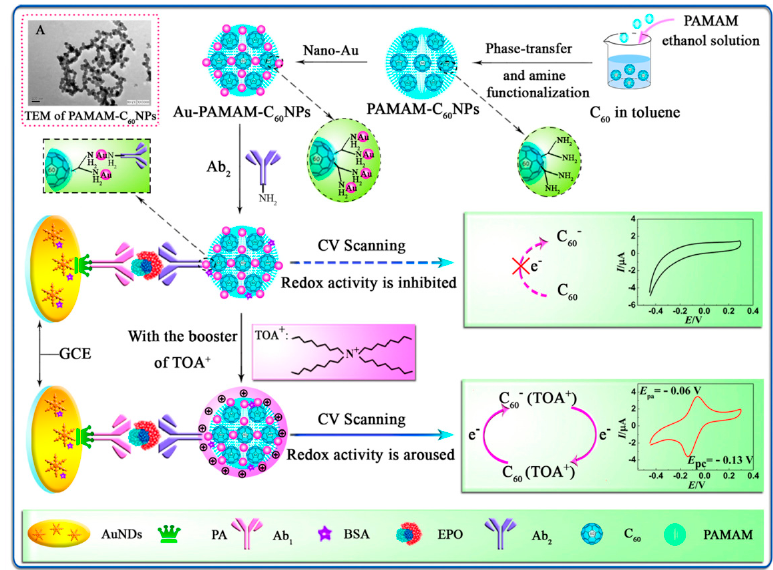
Figure 5. Schematic illustration of the immunosensor preparation process and possible mechanism of electrochemical reaction. Reproduced with permission from [51].